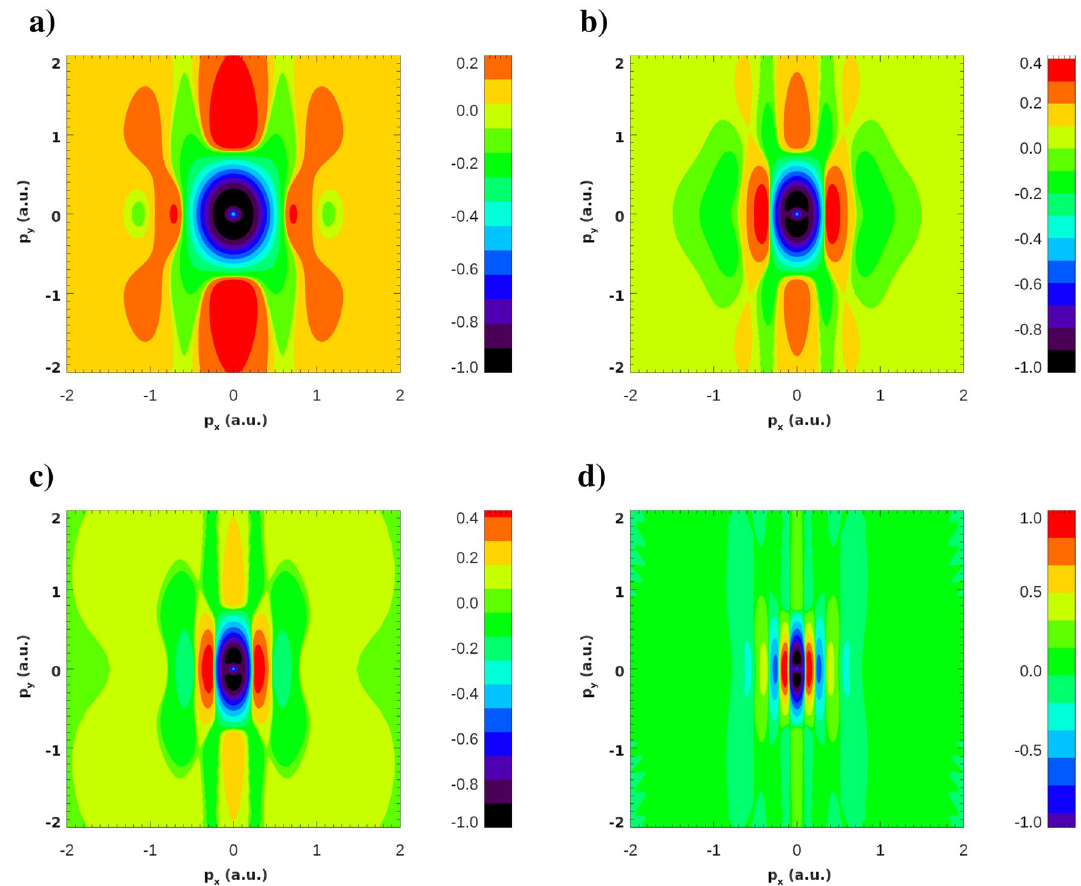
( φ 0 ( p )) of the Fourier transform of the ground state wave-functions of the KH atom. IR ˜ ℜ 0.02387 a.u. ( a ), E 0 0.04 a.u. ( b ), E 0 = = 1 / 3 ( ˜ φ 0 ( p )) is shown for improving the visibility of the patterns. ℜ ( ˜ φ 0 ( p )) max (cid:31) |ℜ | (cid:30)